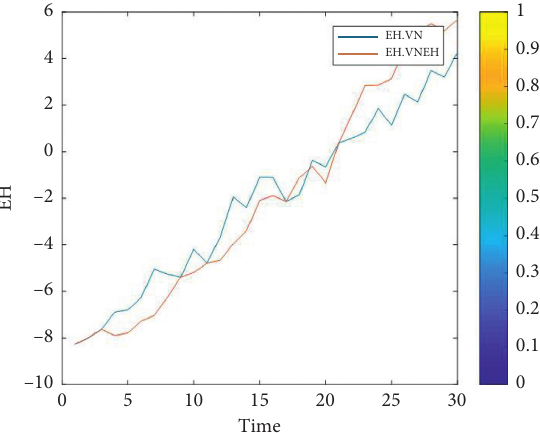
Figure 10: Test results of the effectiveness of Vietnam ʼ s higher education